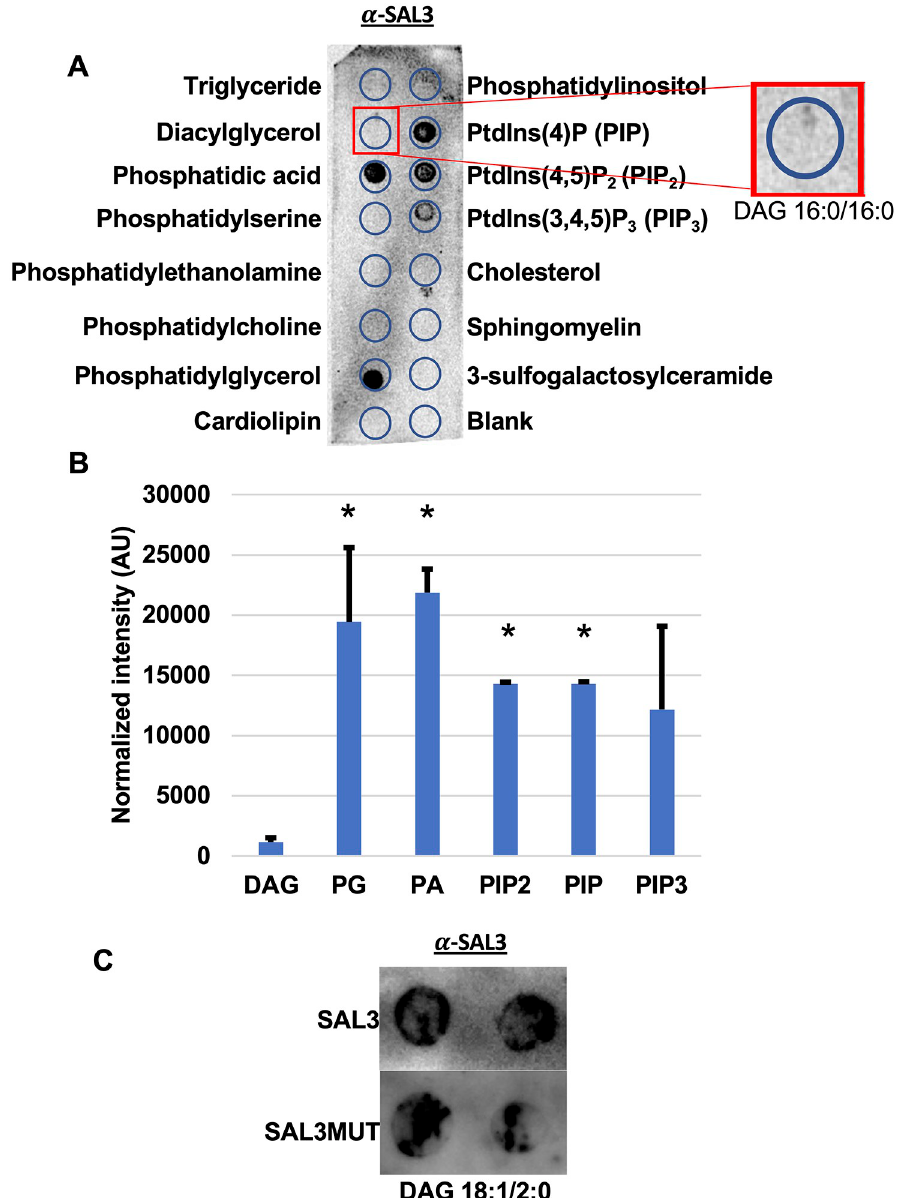
Fig 5. Interaction of SAL3 with membrane lipids. The interaction of SAL3 with membrane lipids was determined using protein lipid overlay assays. A. Lipids to which rSAL3 and rSAL3MUT bound were observed by chemiluminescence. B. Normalized intensity relative to background signal was assessed semi-quantitatively by ImageJ. � p < 0.05. C. A lipid overlay assay was designed to assess the interaction between rSAL3 and 1-oleoyl 2-acetyl glycerol (DAG 18:1/2:0). The two spots are technical